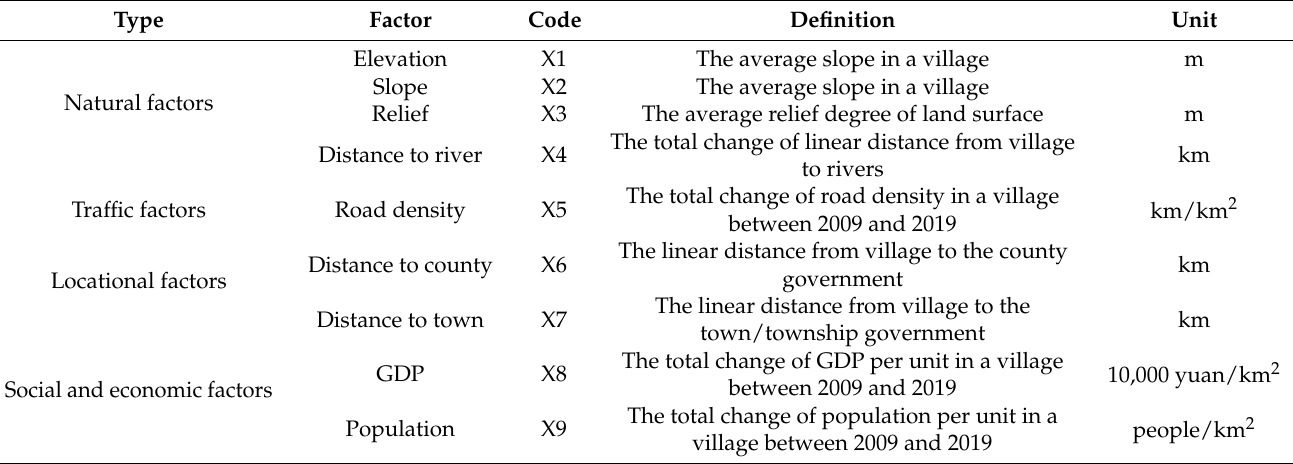
Table 1. Driving factors and their codes, definitions, and